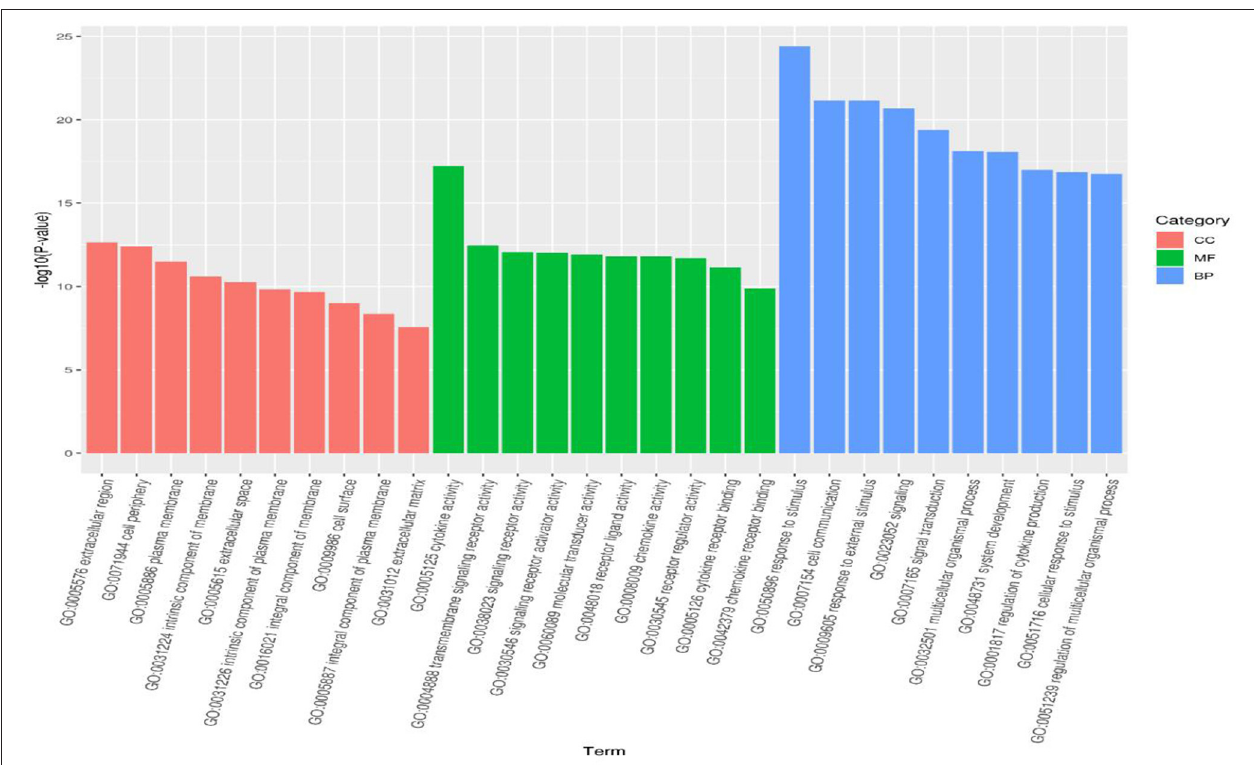
FIGURE 3 | GO analysis for differentially expressed genes identified in the infected groups. The bar diagram displaying the top 10 GO terms of each category the x-axis shows significantly enriched GO terms, and the y-axis shows the -log 10 P -value of these terms. The red, green and blue bars represent “Cellular Component” (CC), “Molecular Function” (MF) and “Biological Process” (BP) categories in GO,